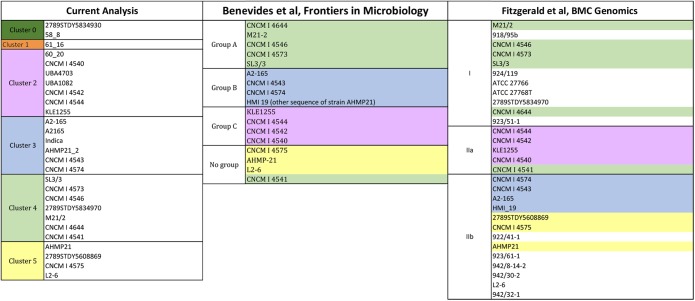
Clustering of strains having F. prausnitzii L2-6 (fpr) as reference. The reference strains is located in cluster 5. Strains per cluster: cluster 0 (58_8 and 2789STDY5834930), in cluster 1 (61_16), in cluster 2 (UBA1082, UBA4703, 60_20, CNCM | 4540, CNCM | 4542, CNCM | 4544, and KLE1255), in cluster 3 (A2165, A2-165, CNCM | 4543, Indica, AHMP-21_2, CNCM | 4574), in cluster 4 (CNCM | 4541, CNCM | 4546, CNCM | 4573, CNCM | 4644, SL3/3, M21/2, and 2789STDY5834970), and in cluster 5 (L2-6, 2789STDY5608869, CNCM | 4575, and AHMP-21).